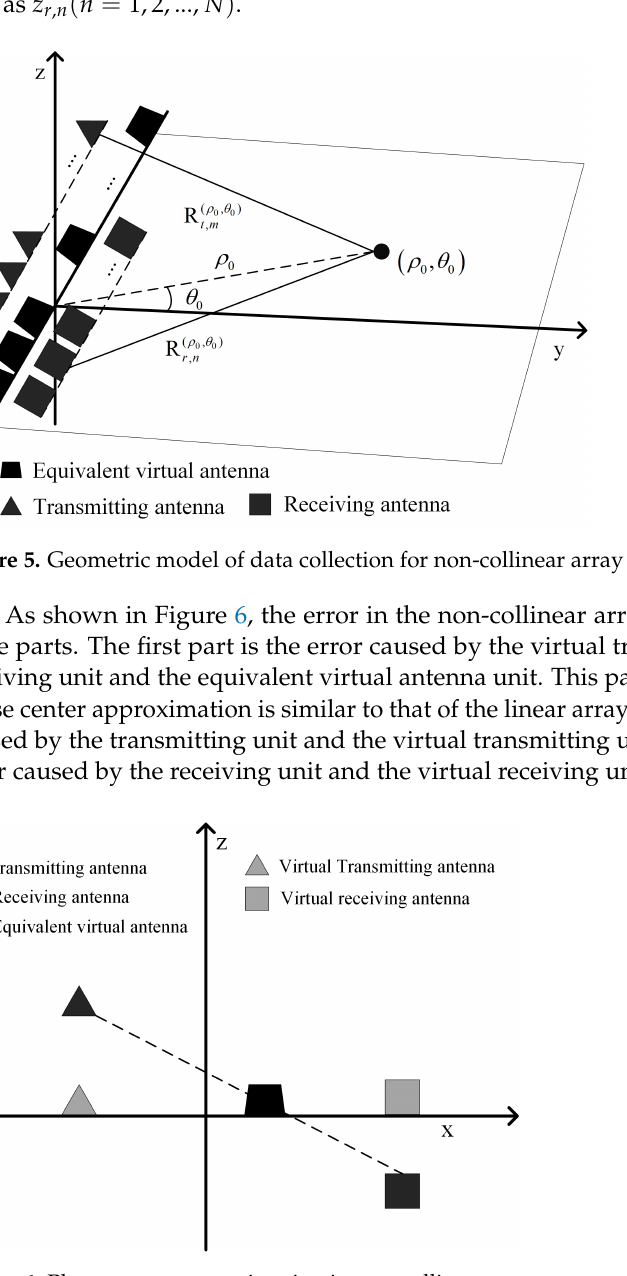
Figure 6. Phase center approximation in non-collinear